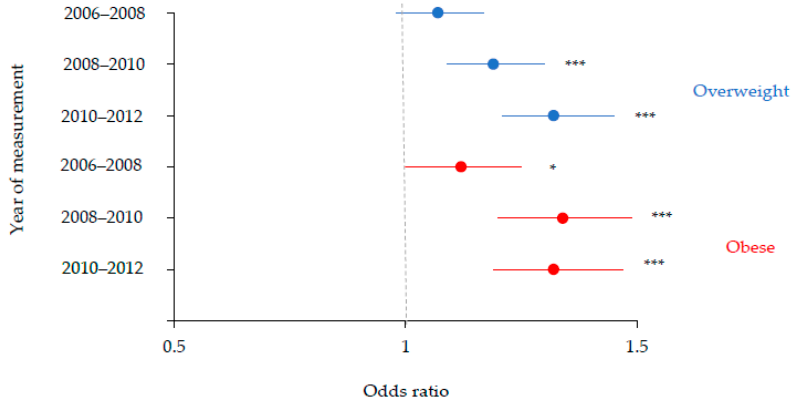
Figure 3. Odds ratios with 95% confidence intervals illustrating associations between deprivation and weight status among Year 6 aged Liverpool children between 2006 and 2012. The highest decile of deprivation was the reference category. Adjusted for gender. * p < 0.05; *** p <